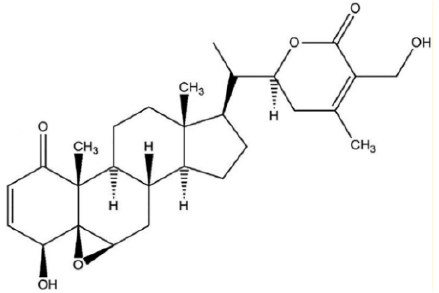
Figure 1. WFA chemical structure.